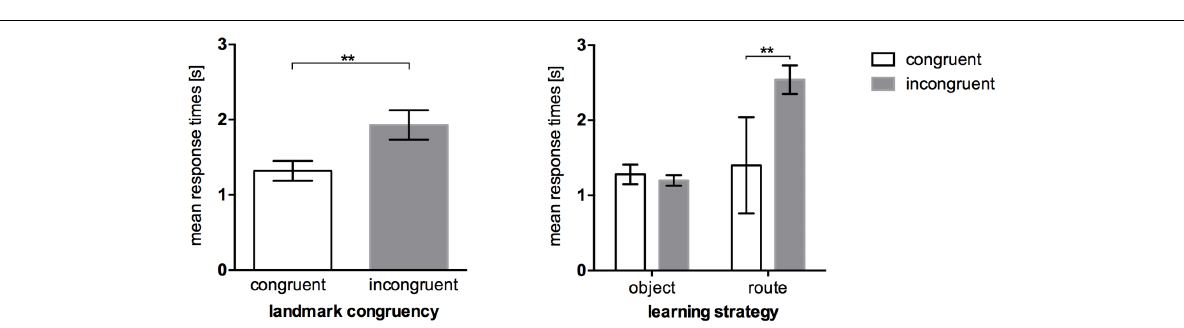
FIGURE 5 | Mean response times of the recognition task in Experiment 2, error bars represent the SEM . (Left) Comparison between response times in the congruent landmark condition and the incongruent landmark condition. (Right) Response times between congruency levels after post hoc categorization of strategies. ∗∗ p <